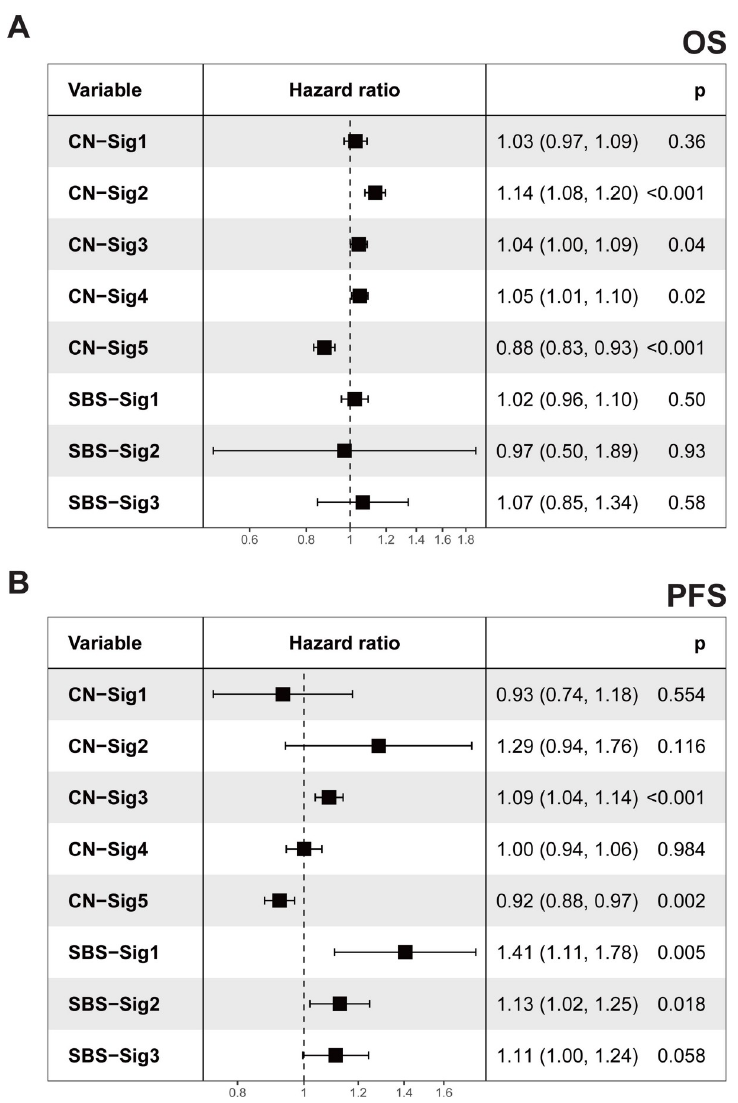
Fig 6. Genome alteration signature exposures and PC survival. (A,B) Forest plots showing the relative risk of signature exposures in overall survival (OS) (A) and progression-free survival (PFS). Due to the availability of clinical information, OS analyzes were performed with phs000178 dataset (TCGA, 498 primary prostate cancer) and phs000554 dataset (48 metastatic prostate cancer), PFS analyzes were performed with phs000178 dataset. (B). Exposures for all signatures were normalized to 1–20 for evaluating the hazard ratios per 5% exposure increase. Hazard ratios and p values were calculated by univariable Cox analysis. Squares represent hazard ratio, horizontal lines indicate the 95% confidence